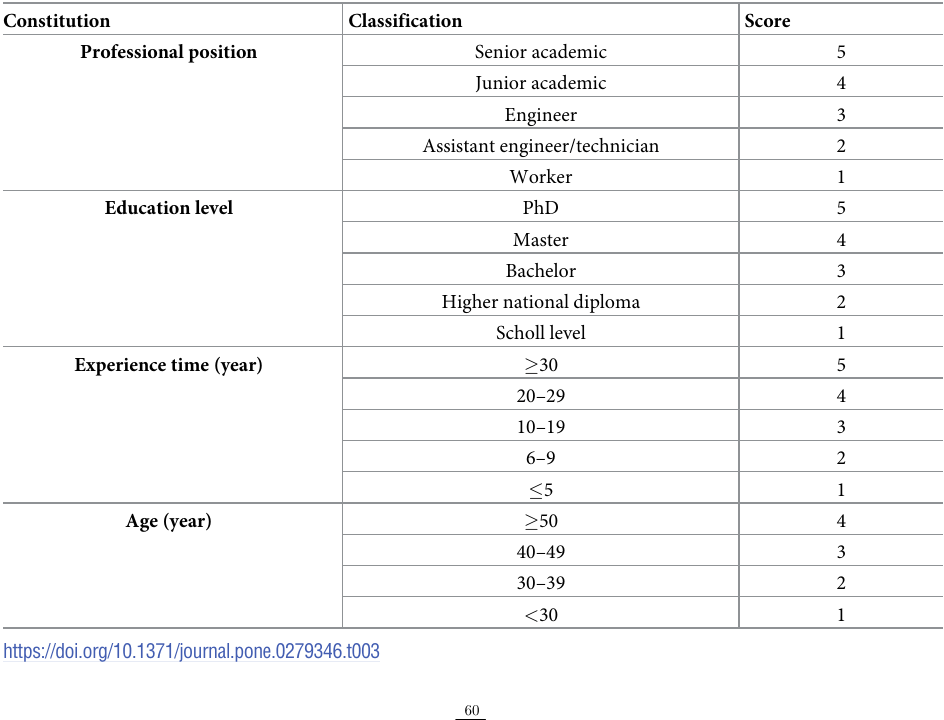
Table 3. Weight of the different expert [44].